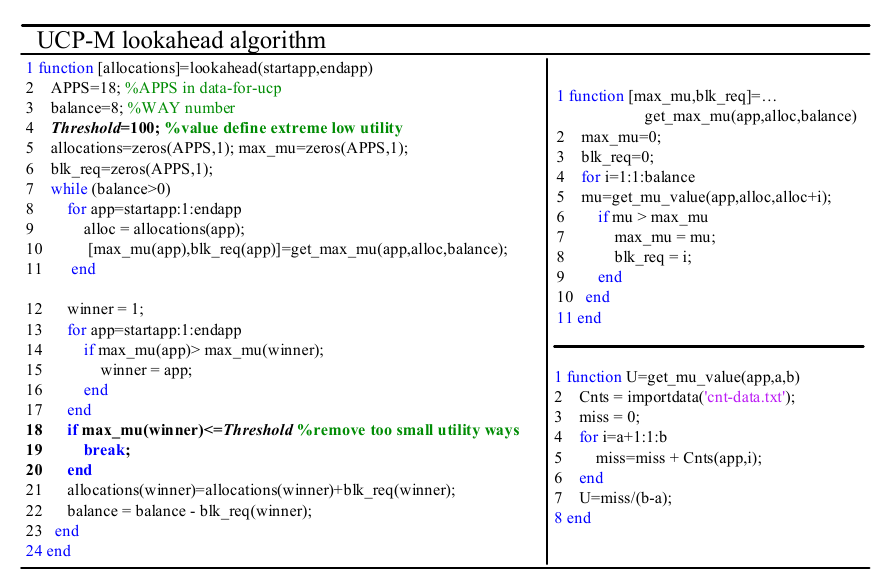
Figure 10. Modified UCP algorithm.